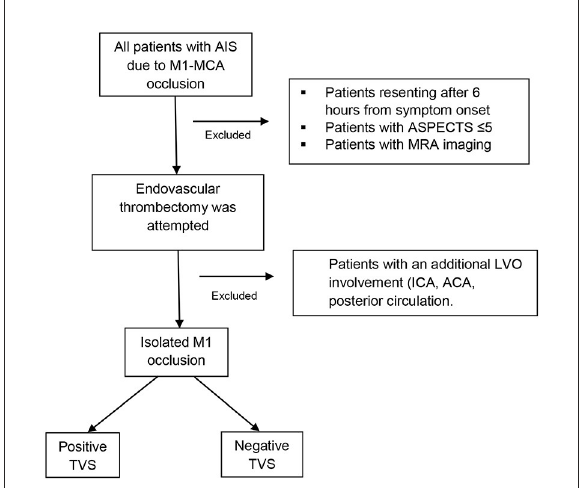
FIGURE1 Flowchart of patient inclusion. AIS, acute ischemic stroke; ED, emergency department; EVT, endovascular treatment; ICA, internal carotid artery; ACA, anterior cerebral